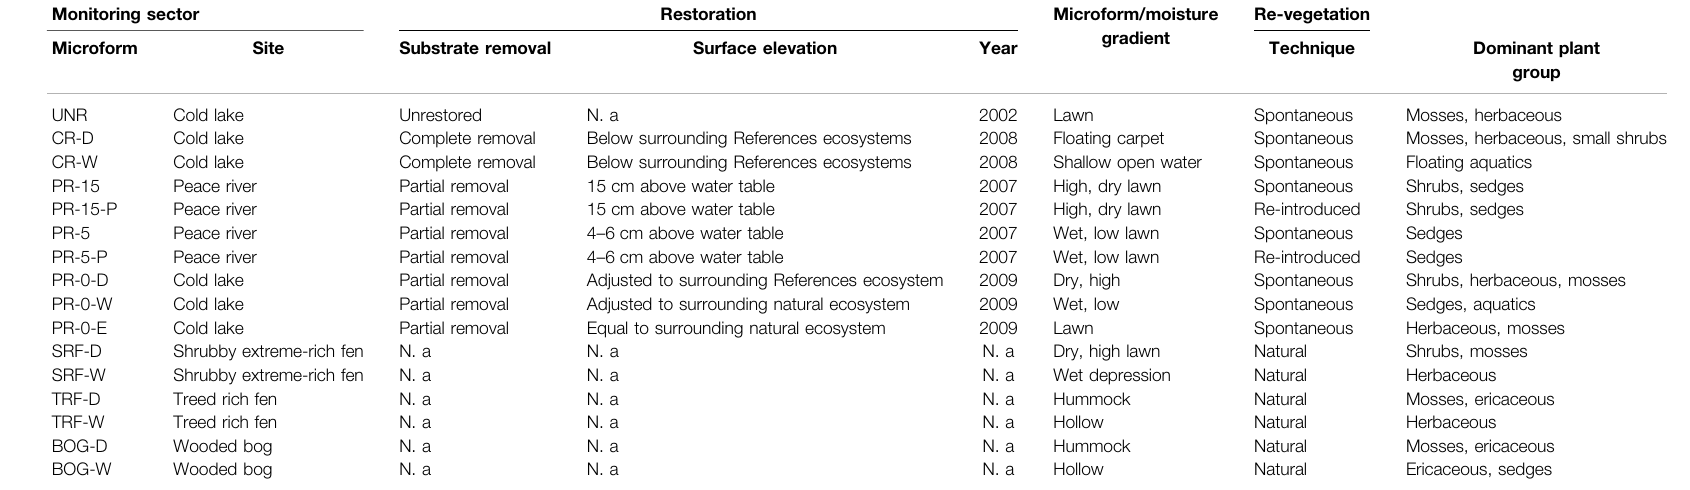
TABLE 1 | Site characteristics for the unrestored and restored sectors on two former in-situ oil sands well sites in Peace River and Cold Lake and three reference sites (SRF, TRF, BOG). Monitoring sectors were selected according to the representativity of the natural state, restoration and re-vegetation